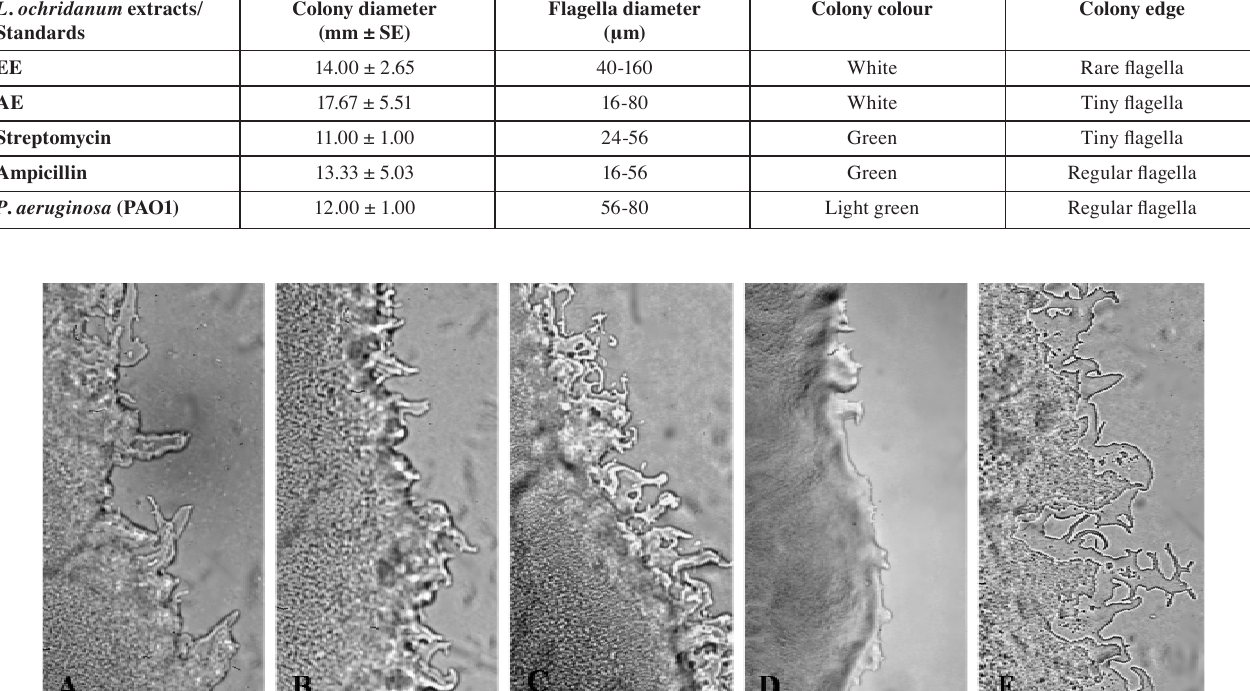
Tab. 6: Effects of L . ochridanum extracts on twitching and flagella motility of P . aeruginosa (PAO1). L . ochridanum extracts/